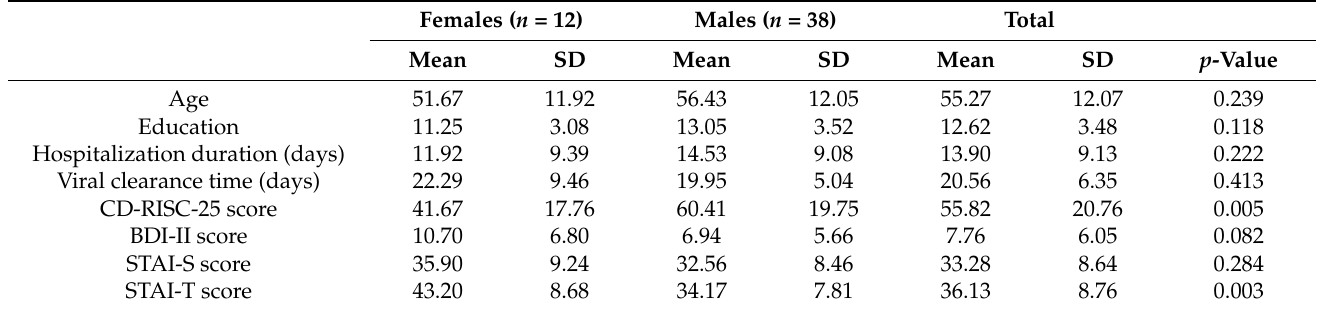
Table 1. Descriptive statistics and differences between males and females.